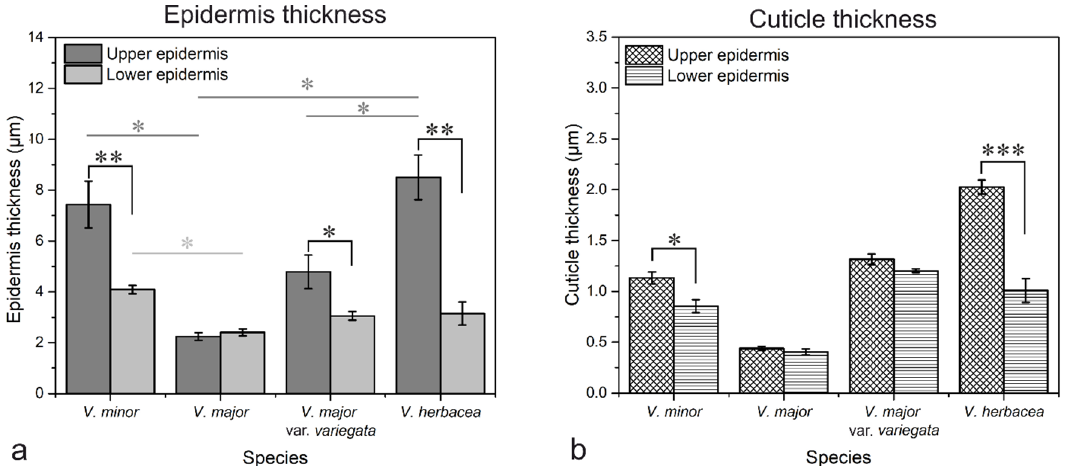
Figure 8. Epidermis ( a ) and cuticle ( b ) measurements showing the differences between the leaves of Vinca plants; each value represents the calculated mean of six independent measurements effectuated along the cell walls and cuticles of at least two different cells *** p < 0.0001, ** p ≤ 0.005, * p ≤ 0.05.